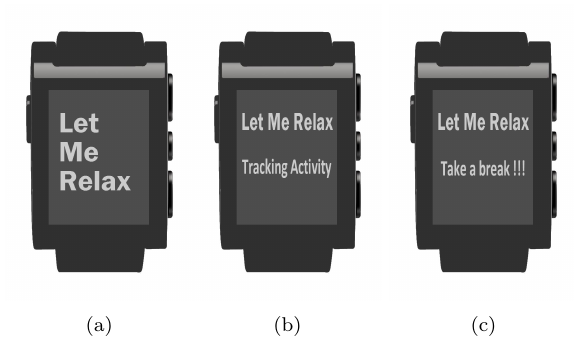
Figure 2: Let Me Relax android application states: (a) Home (b) Deep breathing, (c) Active eye exercise. Image credit: